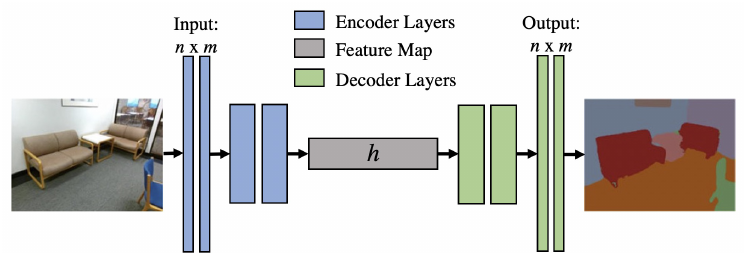
Figure 4. Visualization of an autoencoder architecture. Image segmentation used as an input–output images adapted from